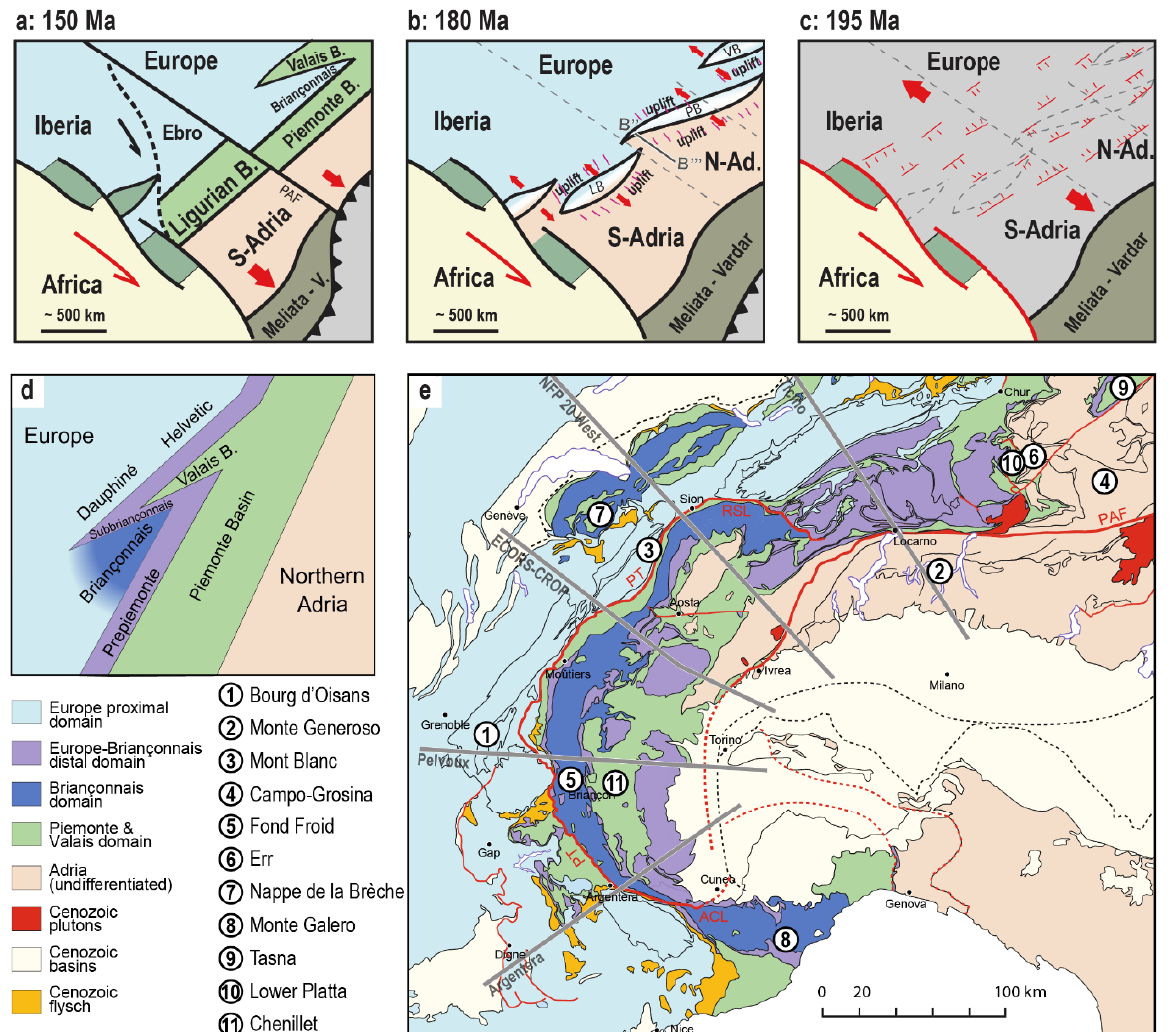
Figure 2. Schematic maps (modified from [19]) showing the paleogeographic evolution of the Alpine Tethys at ( a ) Late Jurassic (150 Ma; assumed end of rifting/spreading in the Alpine Tethys); ( b ) late Pliensbachian (180 Ma; individualization of the Ligurian, Piemonte and Valais basins as en-échelon rift segments separated by accommodation/transfer zones); ( c ) early Jurassic (195 Ma; early rift phase characterized by distributed deformation); Abbreviations: N-Ad., Northern Adria; PAF, Peri-Adriatic Fault; LB/Ligurian B., Ligurian Basin; PB/Piemonte B., Piemonte Basin; VB/Valais B., Valais Basin; LP: Lower-plate rifted margin; UP: Upper-plate rifted margin. ( d ) Schematic paleogeographic map showing the spatial relationships between the Briançonnais ribbon and the Valais and Piemonte domains of the Alpine Tethys. ( e ) Tectonic map of the Western and Central Alps (modified after [24]) displaying the present-day distribution of the paleogeographic domains represented in panel ( d ) and the location of the main outcrops mentioned in the text. Abbreviations: RSL Rhone-Simplon Line, PT: Basal Penninic Thrust, ACL Argentera-Cuneo Line.